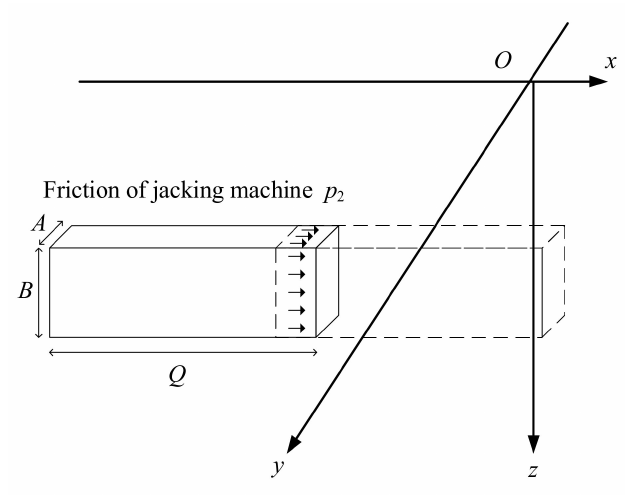
Figure 5. Areas of integration of jacking machine friction. (2) Bottom of pipe jacking